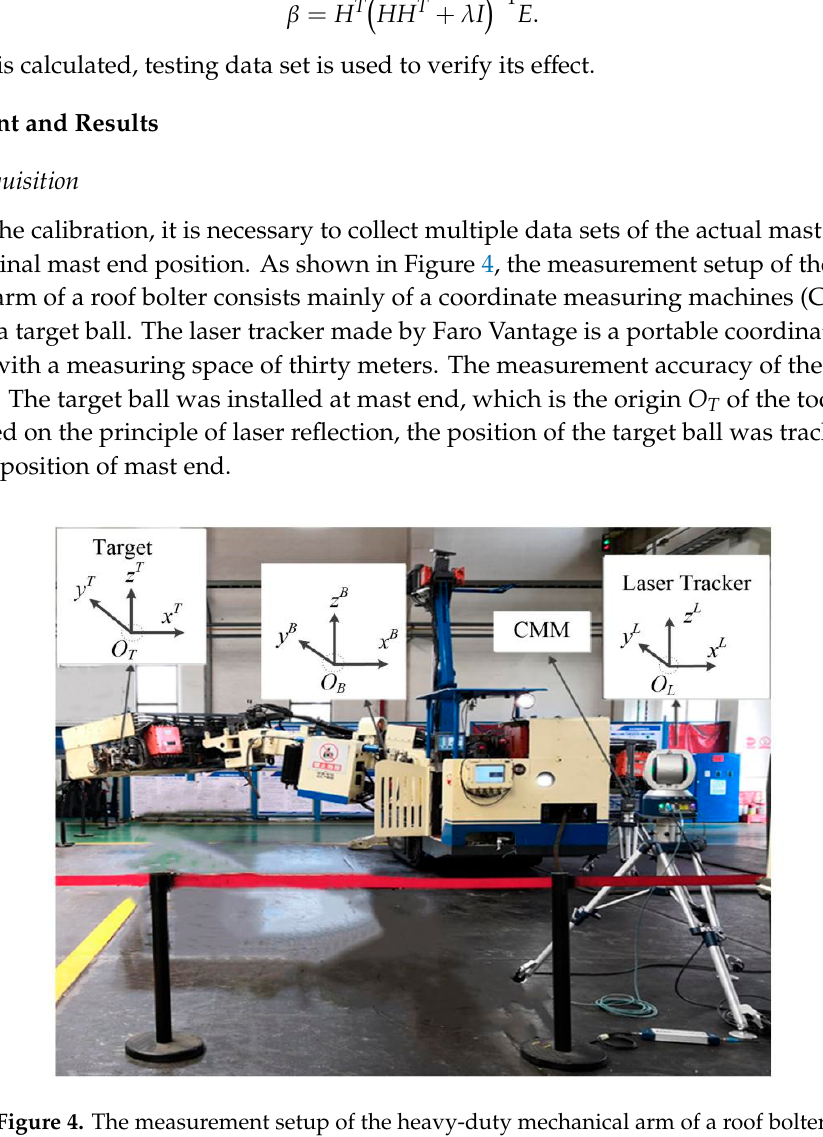
Figure 4. The measurement setup of the heavy-duty mechanical arm of a roof bolter.